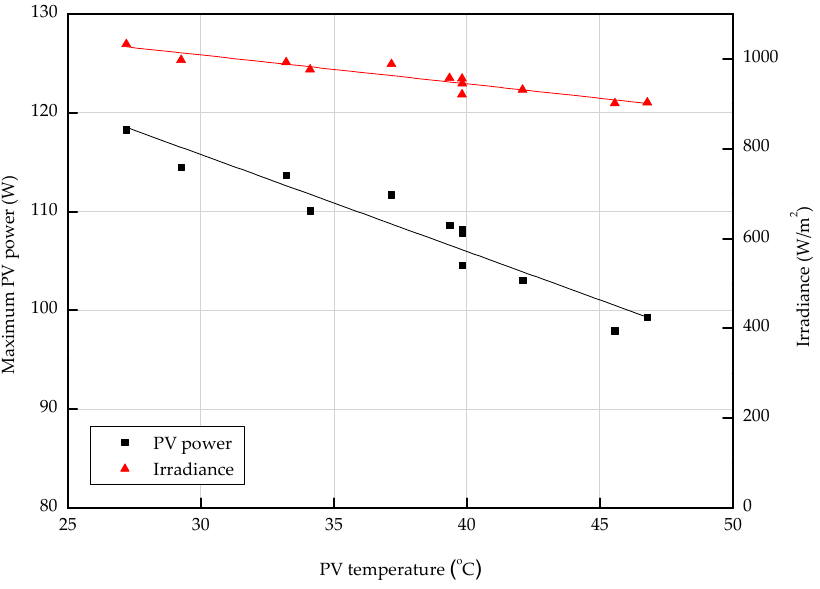
Figure 9. Effect of PV temperature on PV power and temperature.